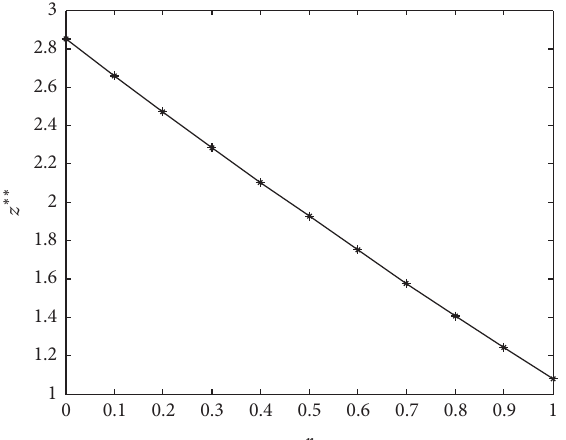
Figure 4: Stocking factor with loan interest rate varying (model M2).